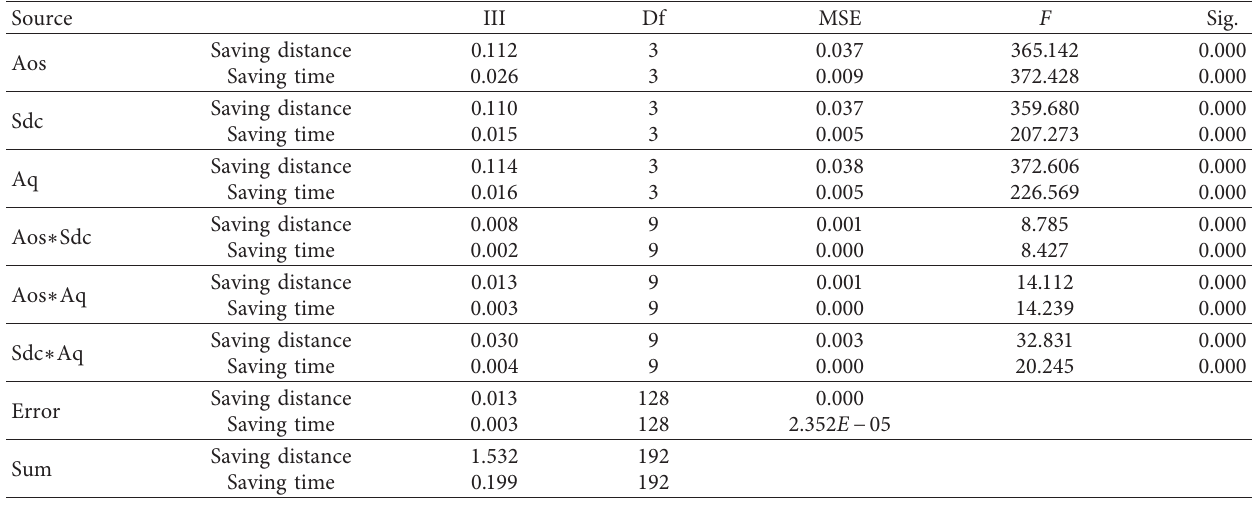
Table 2: Significance tests of optimization effect of DSLA.